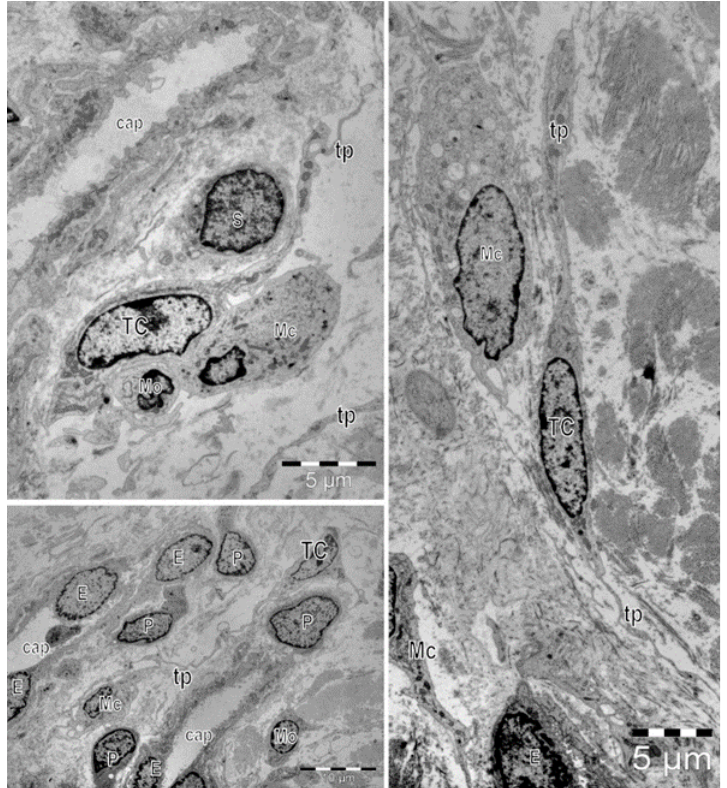
Figure 1. Electron microscopy images show telocytes (TCs) with characteristic long cellular prolongations with uneven caliber, named telopodes (Tps), in a human skin biopsy. TCs are mainly located around capillaries (cap). E — endothelial cell, P — pericyte. Frequently, close vicinity between TCs and other cells located in the interstitium can be observed: Schwan cells (S), macrophages (Mc), and mononuclear cells (Mo).